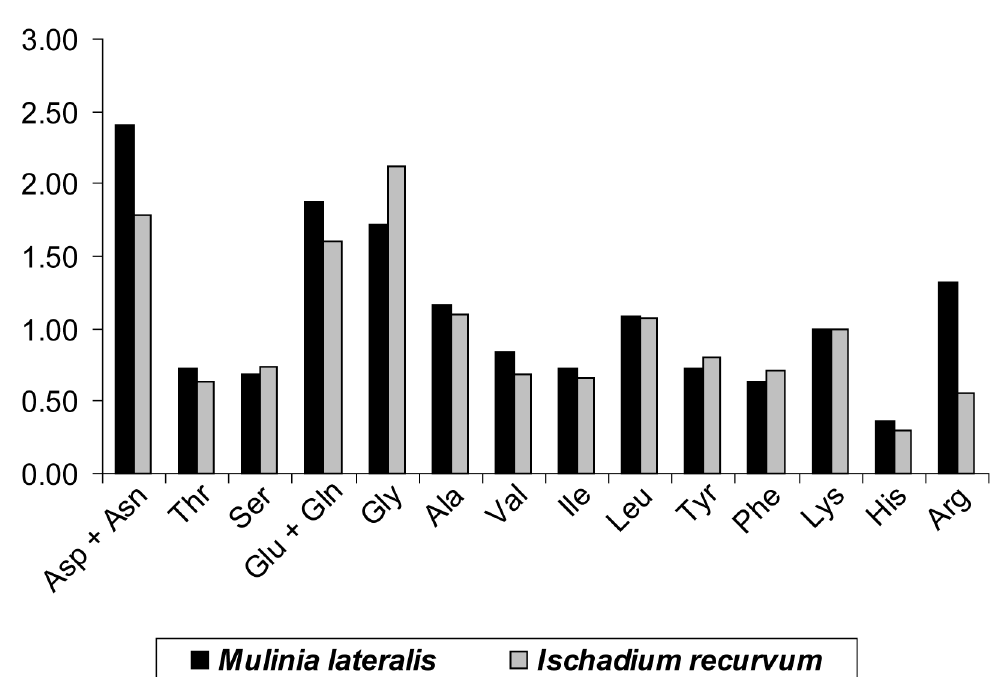
Fig 4. Amino acid amounts relative to lysine for Mulinia lateralis and Ischadium recurvum collected in winter. The amino acid amounts relative to lysine for Mulinia lateralis and Ischadium recurvum collected in winter from the Chesapeake Bay. Asp = Aspartic acid; Asn = Asparagine; Thr = Threonine; Ser = Serine; Glu = Glutamic acid; Gln = Glutamine; Gly = Glycine; Ala = Alanine; Val = Valine; Ile = Isoleucine; Leu = Leucine; Tyr = Tyrosine; Phe = Phenylalanine; Lys = Lysine; His = Histidine; and Arg =